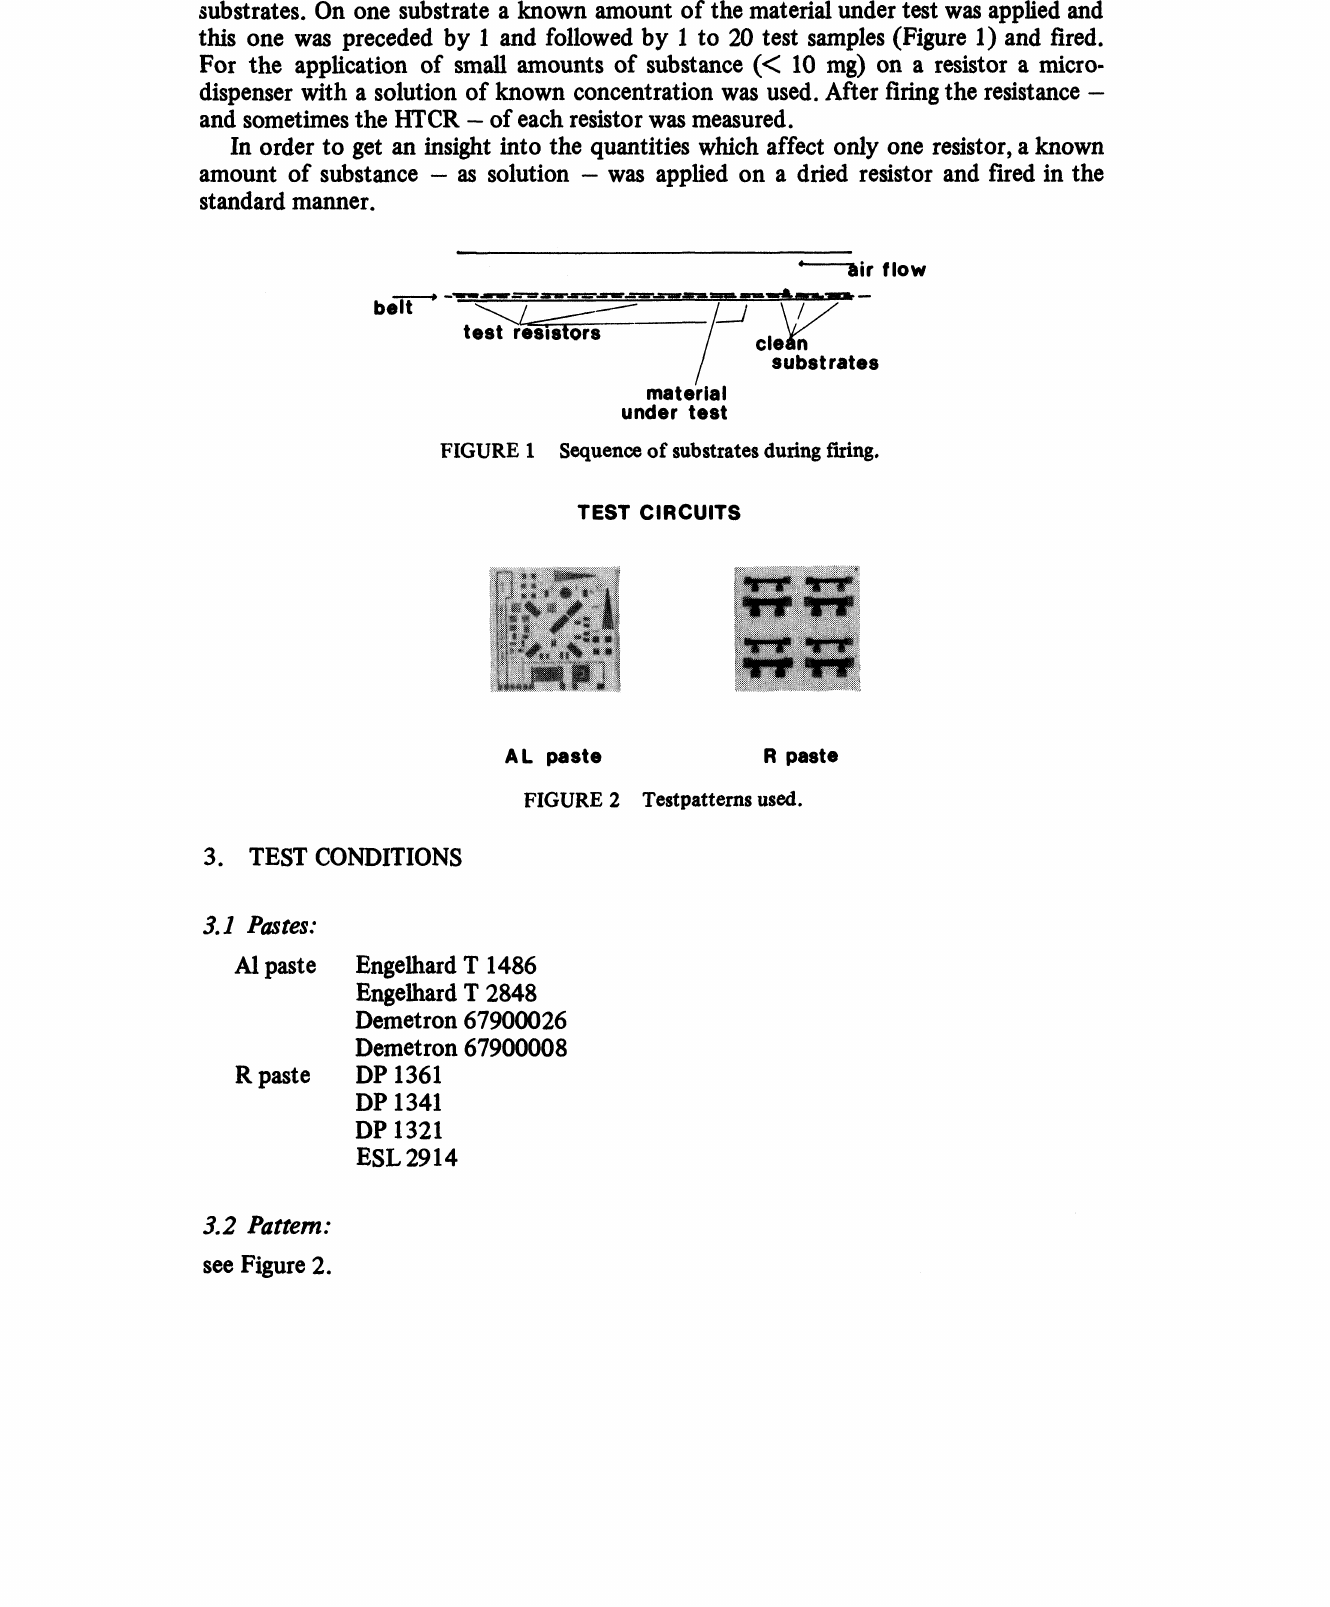
FIGURE 1 Sequence of substrates during firing. TEST CIRCUITS